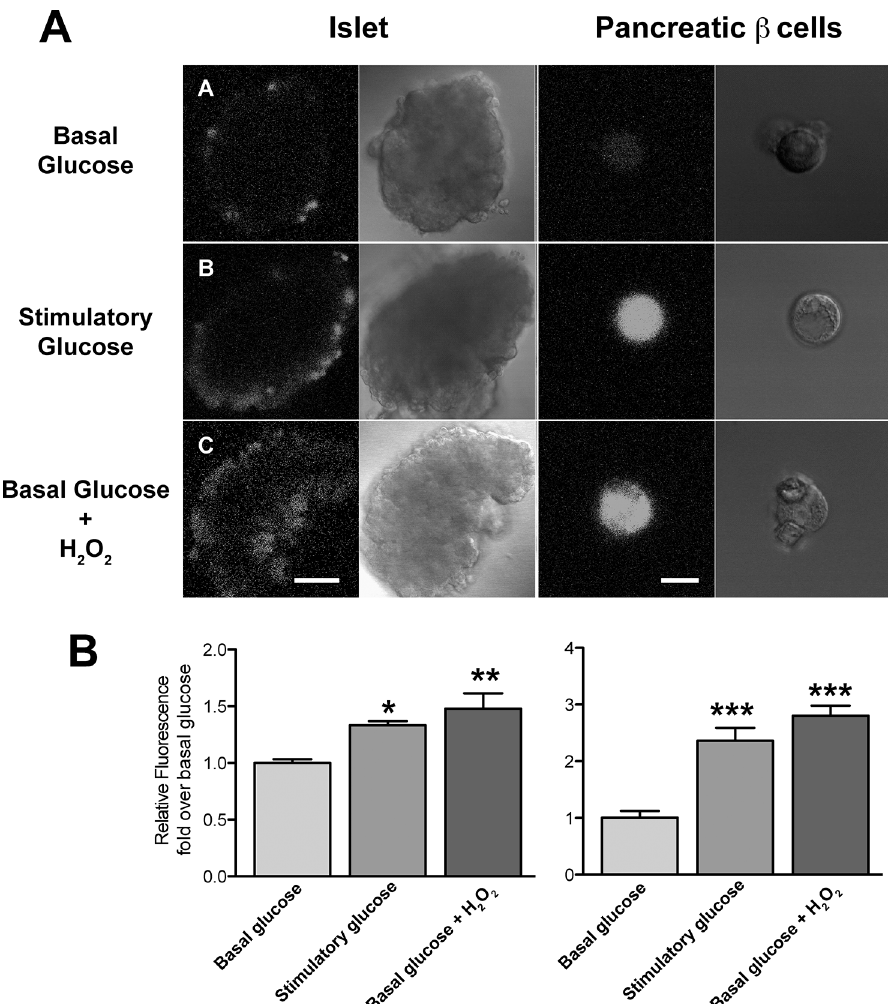
Fig 3. Incubation with exogenous H 2 O 2 or glucose increases ROS generation. ROS accumulation was detected by confocal microscopy in islets or cells loaded with CM-H 2 DCFDA (10 μ M), which cytoplasmic esterase enzymes convert to the redox-sensitive fluorescence reporter H 2 DCFDA. Representative images correspond to isolated islets or pancreatic β -cells incubated for 1 h in Krebs bicarbonate buffer containing: (A) 2.8 mM glucose; (B) 16.7 mM glucose; (C) 2.8 mM glucose plus 100 μ M H 2 O 2 and (D) Quantification of ROS production with the redox-sensitive fluorescence reporter H 2 DCFDA. Similar results were obtained in three independent experiments. Scale bars: 50 μ m, islet; 10 μ m, β -cell. Statistical significance was determined with one-way ANOVA followed by Tukey multiple comparison test. * : p < 0.05; ** : p < 0.01; *** p < 0.001.